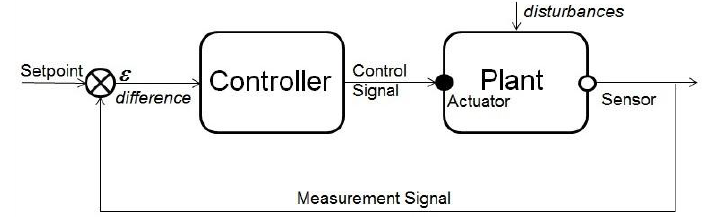
Figure 3. Illustration of a control system influenced by disturbances.